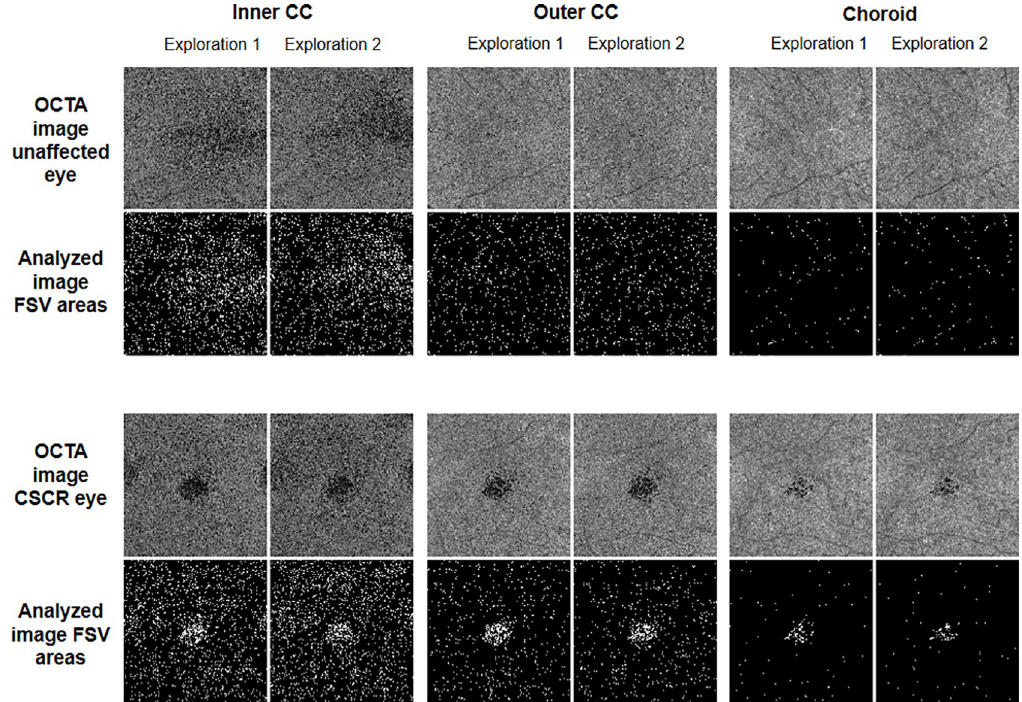
Fig 2. Optical coherence tomography angiography (OCTA) images and the corresponding analyzed images of the flow signal voids (FSV) area of the three slabs studied (inner choriocapillaris, CC; outer CC and choroid) for the exploration 1 and 2 (two consecutive scans separated by a two-minute interval) in central serous chorioretinopathy (CSCR) and fellow eyes.